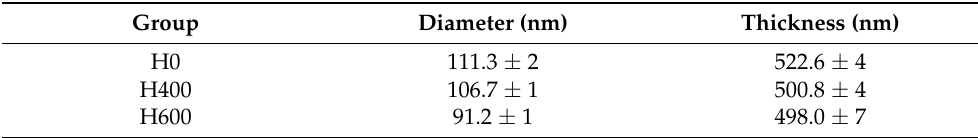
Figure 2. Field emission-scanning electron microscopy images on ( a ) H0, ( b ) H0P, ( c ) H400, ( d ) H400P, ( e ) H600, and ( f ) H600P samples (magnification = 50,000). The mini-subfigures of the left-top corner indicate the height of TiO 2 nanotubes. Table 1. The mean value and standard deviation of TiO 2 nanotubes.